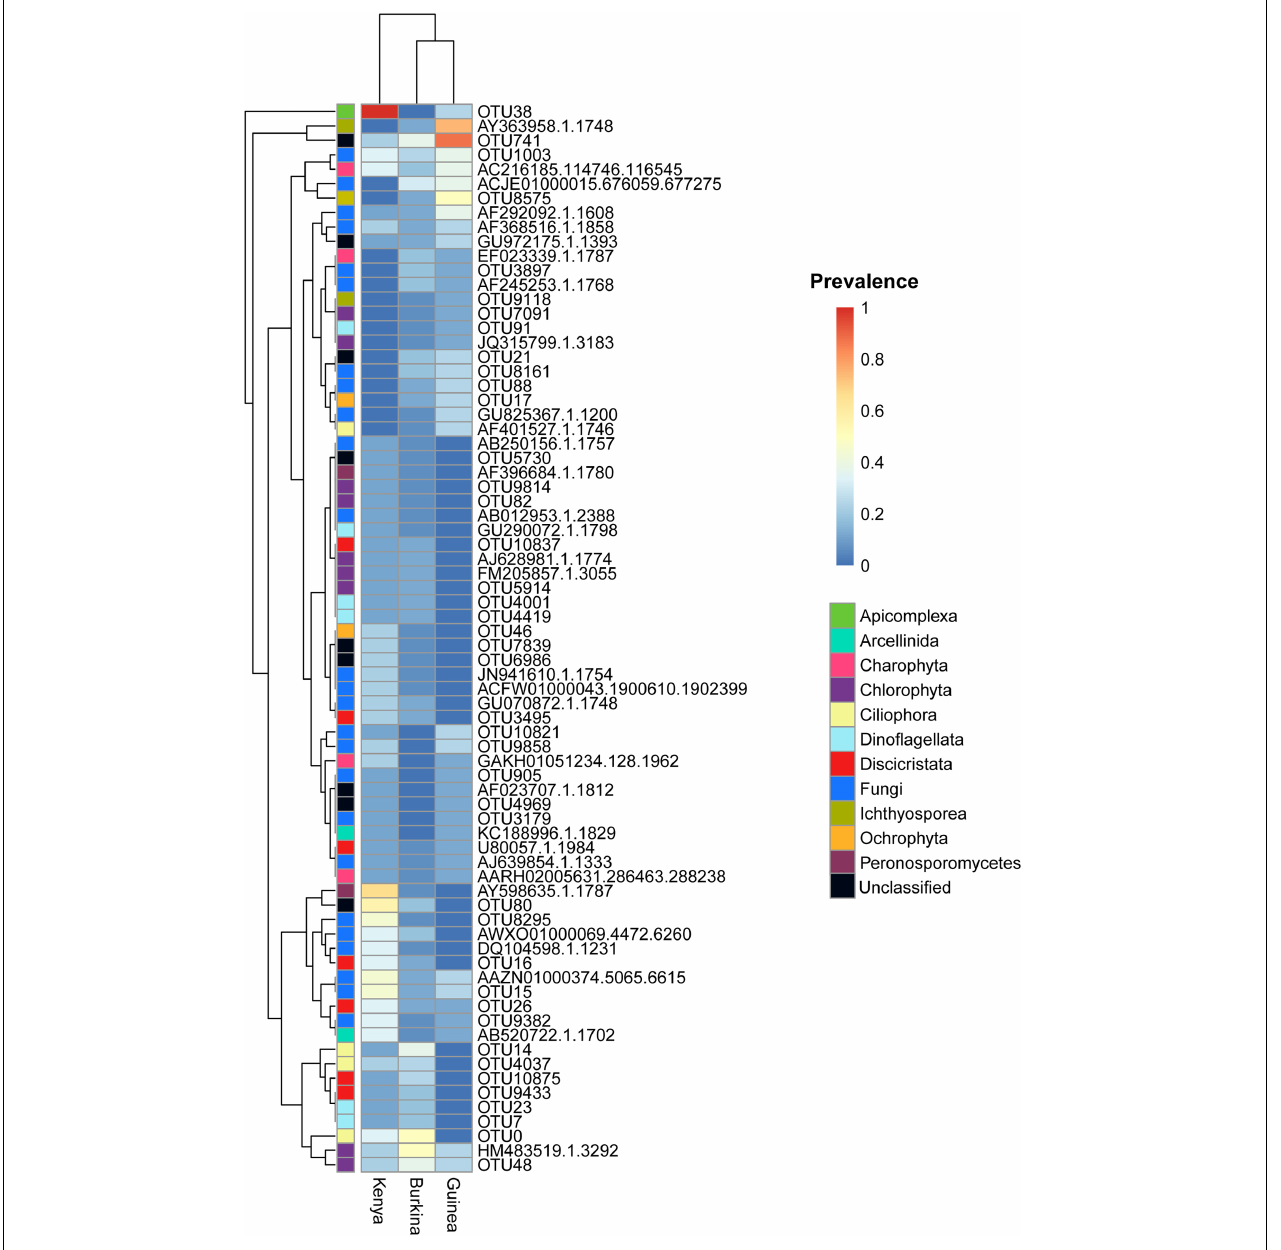
FIGURE 5 | Eukaryotic OTUs detected in mosquito larvae display significant heterogeneity in abundance within and across countries. The heatmap includes the 74 eukaryotic OTUs detected in mosquito larvae collected in at least 2 countries. OTU prevalence is computed as the number of DNA pools with non-zero OTU abundance divided by the number of DNA pools from each country [ n = 15 (Burkina), 8 (Guinea), and 9 (Kenya)]. The left most column is colored to indicate taxonomic ranks in the SILVA119 reference taxonomy. Black phylogenetic ranks correspond to unclassified OTUs by both sequence similarity and phylogenetic